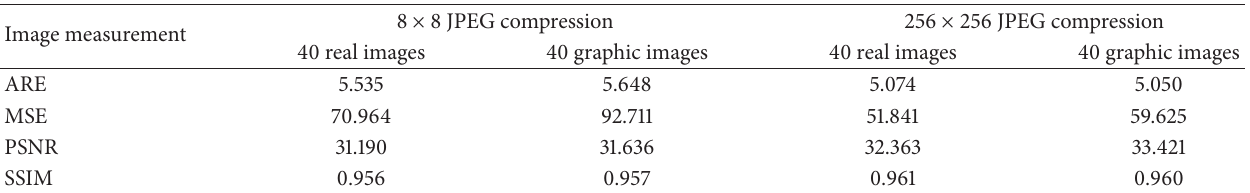
Table5:Theaverageimagereconstructionerrorusing8 × 8JPEGcompressionand256 × 256JPEGcompressionusingpsychovisualthreshold for 40 real images and 40 graphical images.